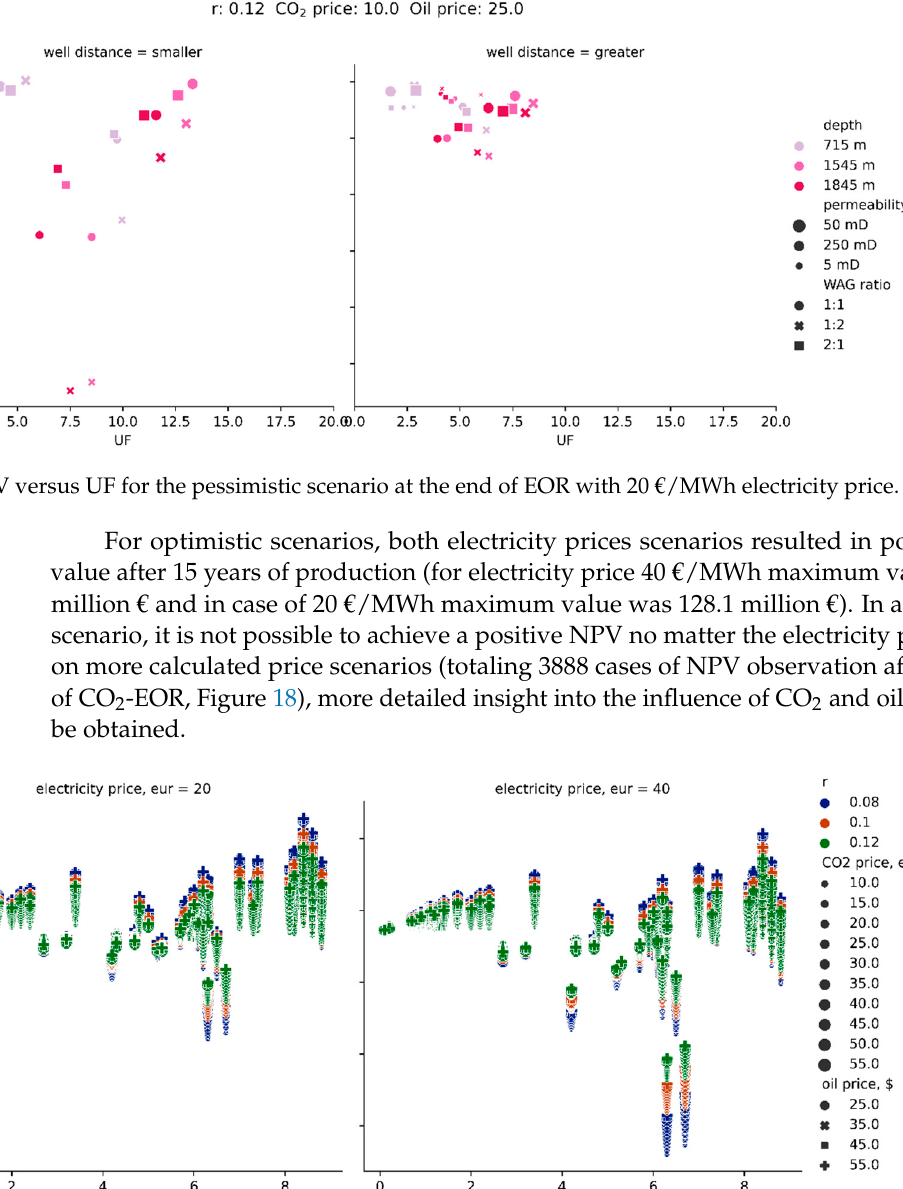
Figure 16. NPV versus UF for the pessimistic scenario at the end of EOR with 40 €/MWh electricity price.